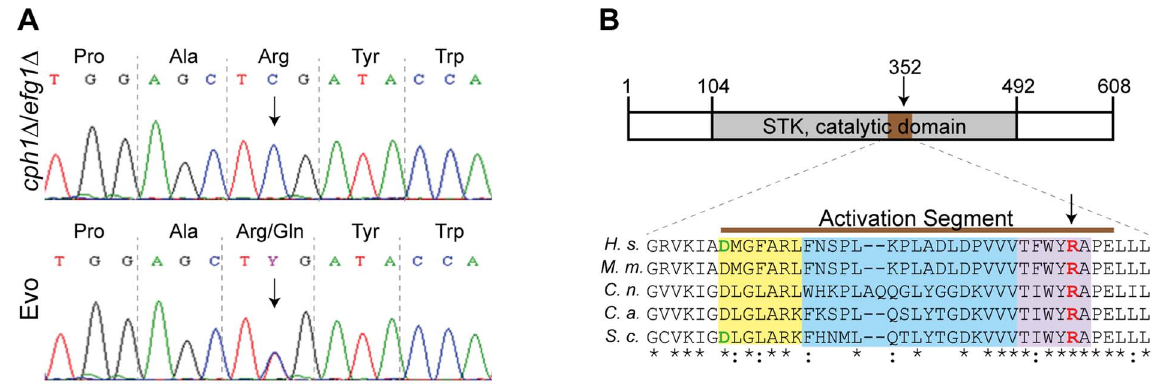
Fig. 6. Single nucleotide polymorphism in SSN3 of the Evo strain and location of the mutated amino acid. ( A ) Partial SSN3 sequence for cph1 D / efg1 D and Evo strains flanking SNP 1055 (marked with an arrow). Notice the heterozygosity in the Evo strain. ( B ) Schematic view of the catalytic domain of Ssn3 (STK=serine/threonine kinase) with the position of the activation segment highlighted in brown and the amino acid exchange indicated by an arrow (top). Sequence alignment of the Ssn3 activation segment in different species ( H. s. Homo sapiens [NP_001251.1], M. m. Mus musculus [NP_705827.2], C. n. Cryptococcus neoformans [XP_568416.1], C. a. C. albicans [XP_720918.1] and S. c. Saccharomyces cerevisiae [NP_015283.1]). The arrow indicates the amino acid exchange in the Evo strain. The Mg-binding loop is highlighted in yellow, the activation loop in blue and the P + 1 loop in purple. Amino acids that are known to abrogate kinase activity when mutated are colored in green [51,98]. Asterisks underneath the alignment indicate positions with conserved amino acids and colons indicate highly similar residues (bottom). The mutated arginine (red) is part of the highly conserved P + 1 substrate recognition loop.